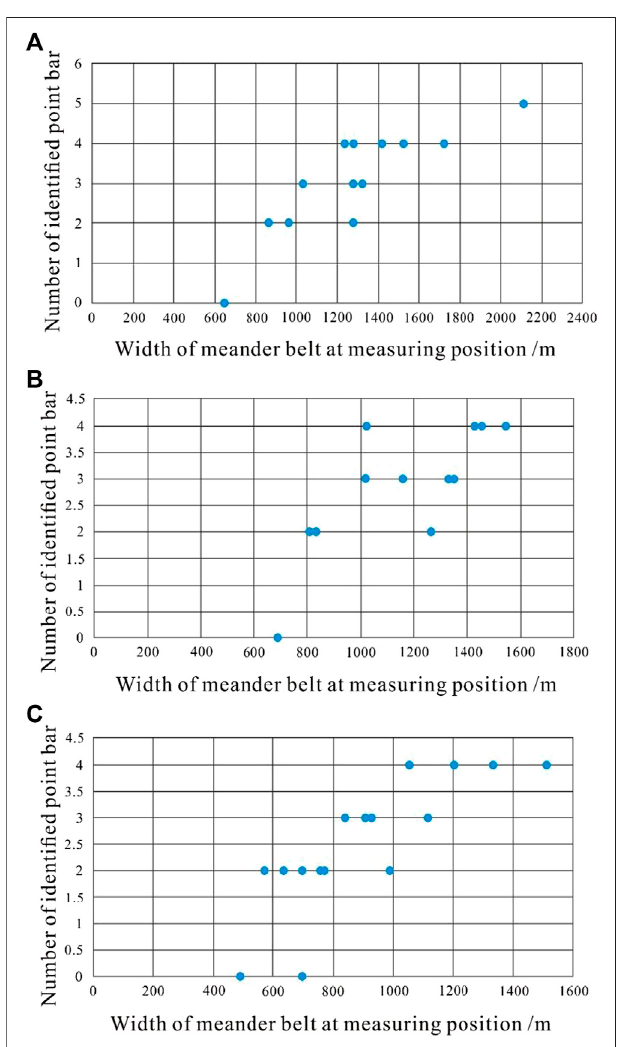
FIGURE 11 | (A) Relationship between the width of the meander belt and the number of identi fi able point bars in Ng33 sub-layer. (B) Relationship between the width of the meander belt and the number of identi fi able point bars in Ng42 sub-layer. (C) Relationship between the width of the meander belt and the number of identi fi able point bars in Ng45